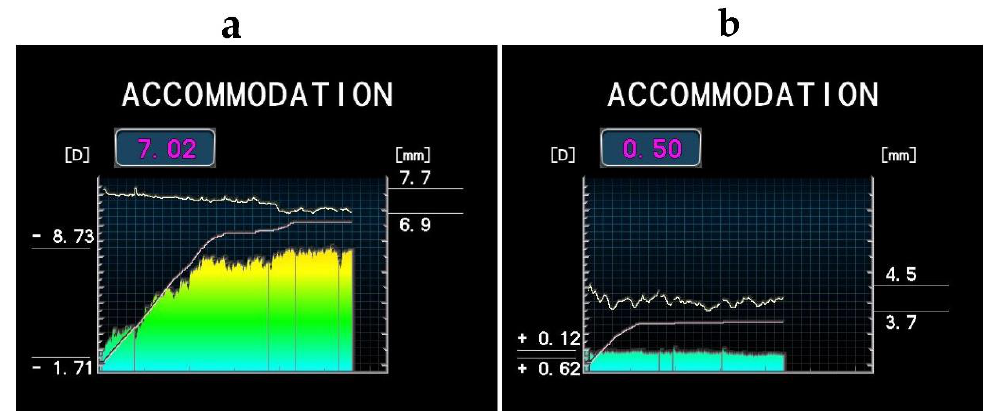
Figure 1. Amplitude of accommodation (AA) and pupil size assessed during the AA measurement in a 25-year-old female ( a ) and a 53-year-old female ( b ). The horizontal axis shows the examination time (up to 30 s). The colored bars represent the real-time refraction, and the lower continuous line represents the internal target position. On the left vertical axis, the minimal and maximal AA values are presented, while the AA magnitude is presented in the box above the chart. The right vertical axis indicates the minimal and maximal pupillary diameter (continuous pupil size assessment is shown as the upper line). All images were obtained with TONOREF IIIL and reproduced with permission from [17].